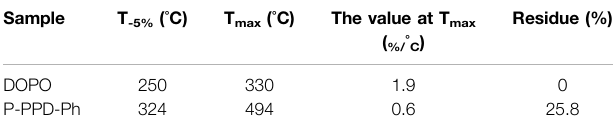
TABLE 1 | Data derived from TG